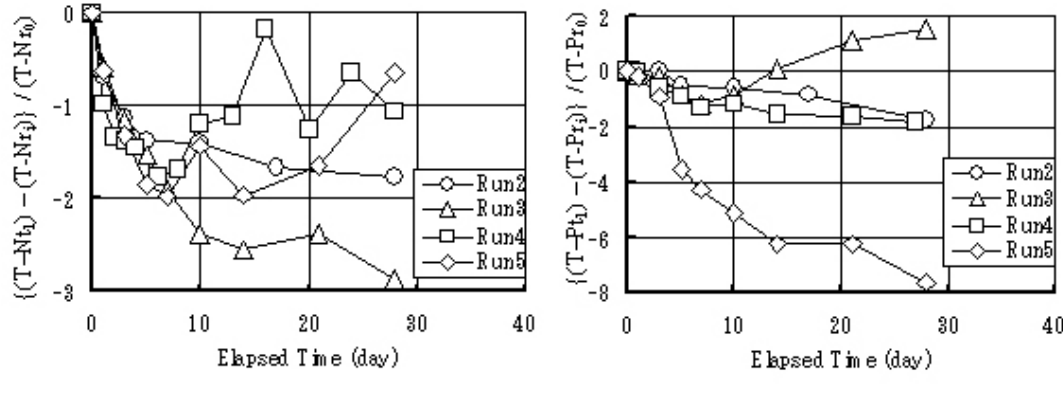
FIGURE 2 . Restraint effect on total nitrogen (T-N). FIGURE 3 . Restraint effect on total phosphorus